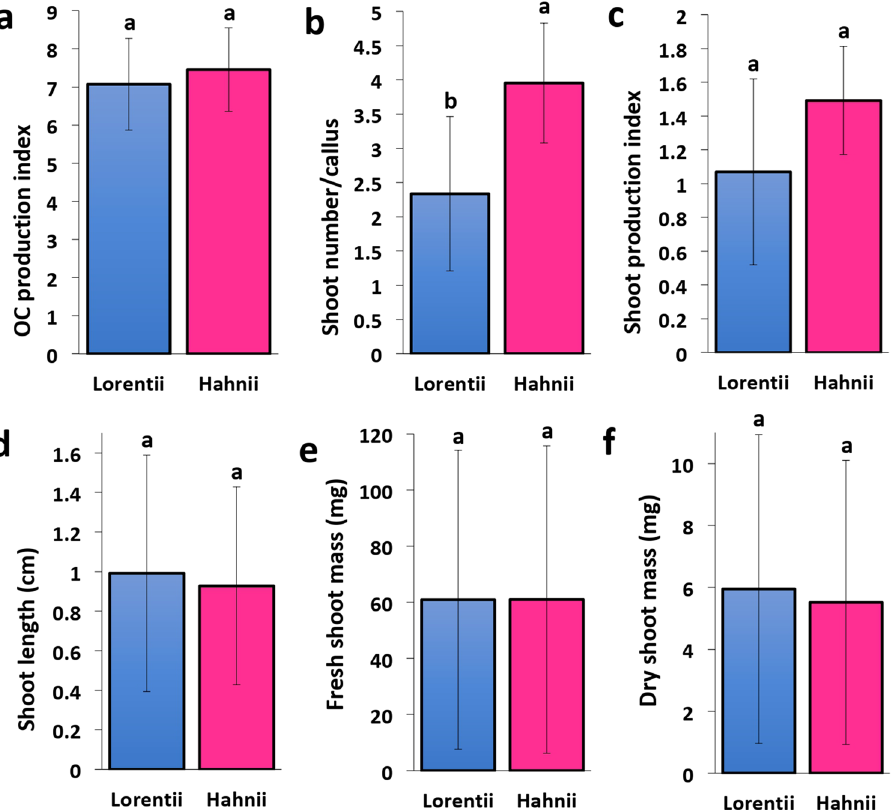
Figure 6. Shoot production by cvs Lorentii and Hahnii of Sansevieria trifasciata . ( a ) OC production index, ( b ) shoot number/callus, ( c ) shoot production index, ( d ) shoot length, ( e ) fresh shoot mass, and ( f ) dry shoot mass were evaluated after 4 weeks of growth on 1X MS medium + 6-benzylaminopurine (BAP) at 4.0 mg·Lˉ 1 . OC = Organogenic callus. Values are means ± SD. Means with different letters are significantly different according Tukey’s test ( p ≤